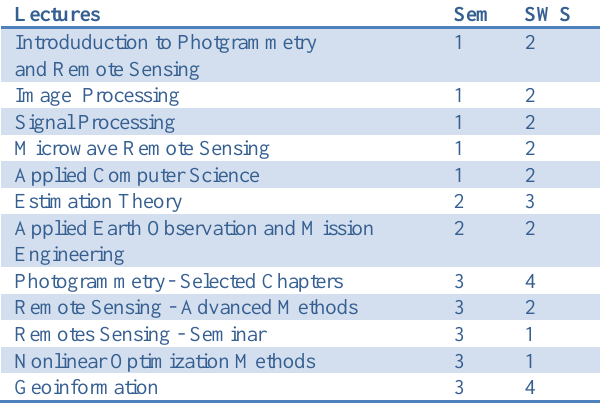
Table 3. Lectures related to photogrametry and remote sensing